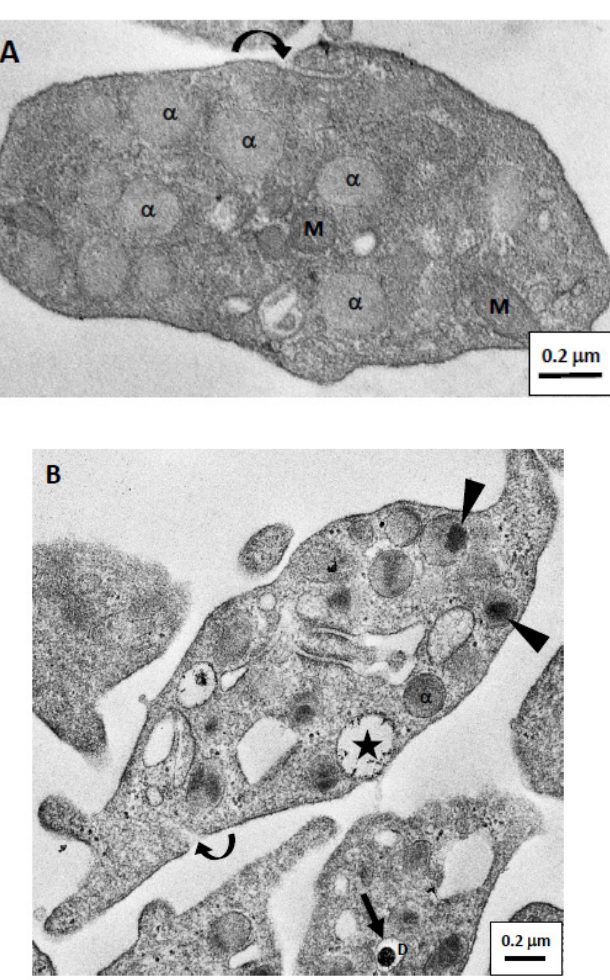
Figure 2. Electron micrographs of resting and active human platelets. ( A ) A resting platelet is oval (with a long axis length of about 2 μ m), and filled with many membrane-bound granules. Most of these granules were α -granules of about 200 nm in diameter that contained gray homogeneous substances. In addition, we could identify mitochondria and small vesicles in the cytoplasm. However, no dense granule was observed in this figure. The curved arrow indicates an opening of an open canalicular system (OCS) on the surface membrane of the resting platelet. ( B ) The active platelet showed the extended pseudopods. The α -granules in the active platelets had a more-dense electron core (indicated by arrowheads) after activation. The curved arrow also indicates an opening of OCS on the surface membrane of the active platelet. In addition, we observed that granule substances were released from the membrane because the granule was in contact with the membrane and liquid substances were exuded (indicated by asterisk). A dense granule with a high-density core surrounded by a stain-free rim (indicated by arrow) can be seen in another platelet below the picture. α , α -granule; D, dense granule; M, mitochondria; scale bar, 0.2 μ m.